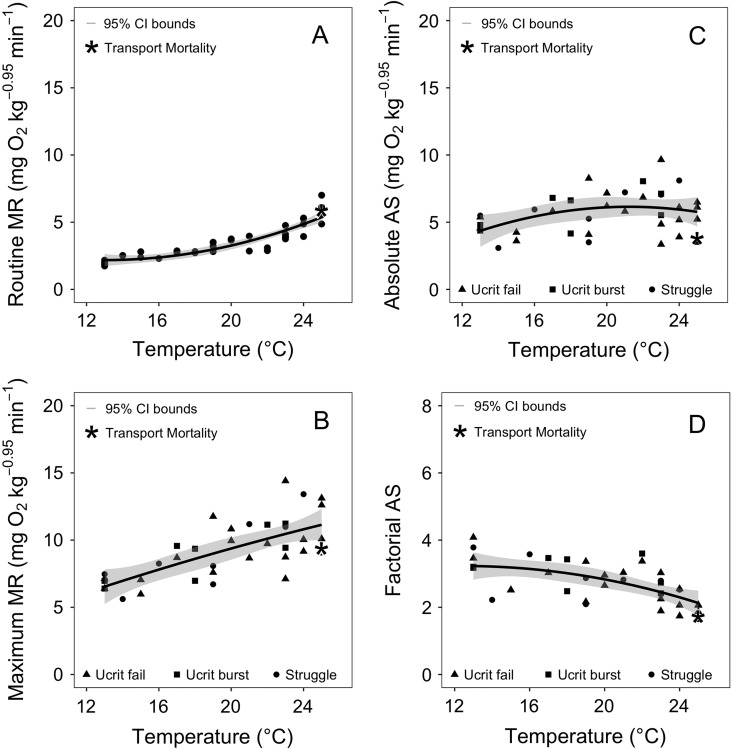
The relationships between test temperature and the routine (RMR; A) and maximal metabolic rate (MMR; B) of Tuolumne River Oncorhynchus mykiss. The three methods used to measure MMR (see Materials and methods section) are distinguished by different symbols. Absolute aerobic scope (AAS; C) and factorial aerobic scope (FAS; D) were derived from the metabolic rate measurements. Each data point represents an individual fish tested at one temperature. These data were given a best-fit mathematical model (continuous line or curve), and the 95% confidence intervals for each line are indicated by the shaded area. The RMR and FAS were smoothed to a polynomial fit of the form y = x + I(x2), where y is RMR or FAS, x is temperature, and I is a constant. The MMR and AAS were smoothed to a linear fit of the form y = x + c, where c is a constant. For RMR, degrees of freedom (d.f.) = 34, P < 0.001, residual standard error (RSE) = 0.561 and r2 = 0.798. For MMR, d.f. = 35, P < 0.001, RSE = 1.580 and r2 = 0.489. For AAS, d.f. = 35, P = 0.060, RSE = 1.490 and r2 = 0.098. For FAS, d.f. = 34, P < 0.001, RSE = 0.506 and r2 = 0.344. The asterisk indicates the one fish that died abruptly after the swimming test.